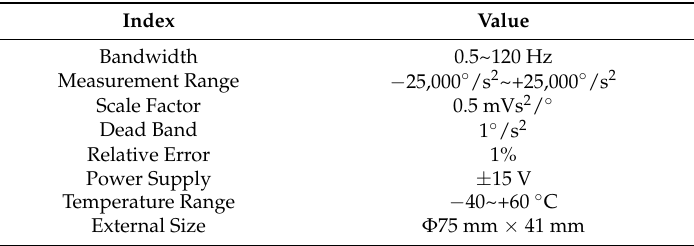
Table 5. Indexes of